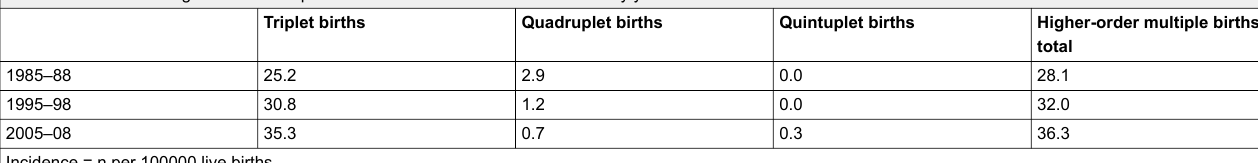
Table 1: Incidence of higher-order multiple births in Switzerland over the last twenty years.